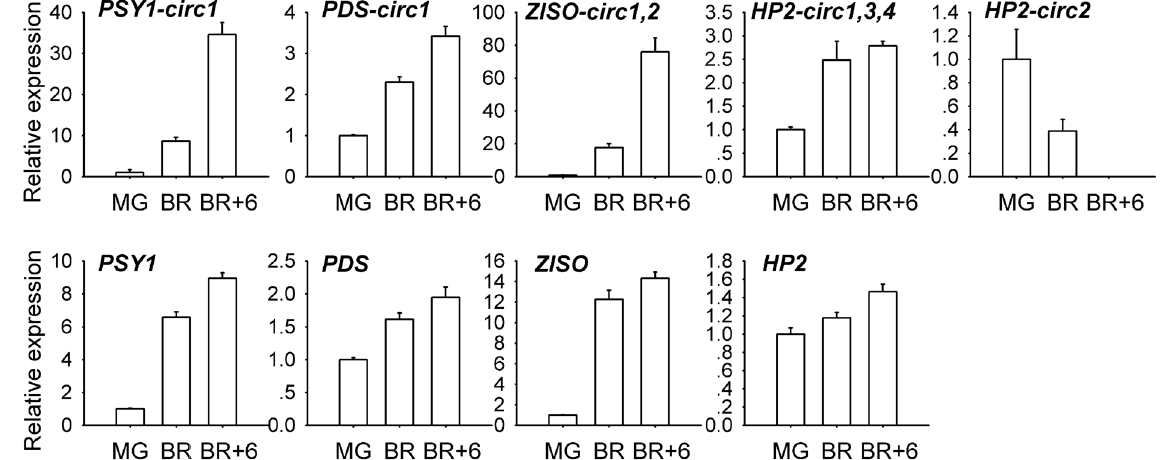
Figure 3. Expression profiling of a few circRNAs and their parent genes in Ailsa Craig fruits at different ripening stages. The data were normalized to Actin (NM_001321306.1) and presented as the means ± SD (Standard Deviation, n = 3). MG, mature green. BR,